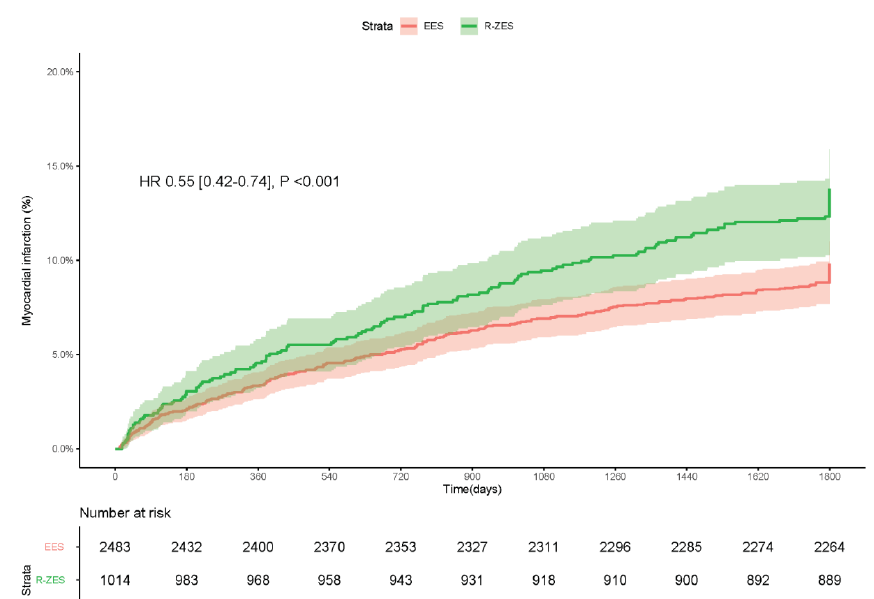
Figure 4. Kaplan–Meier graph of the cumulative incidence of myocardial infarction.